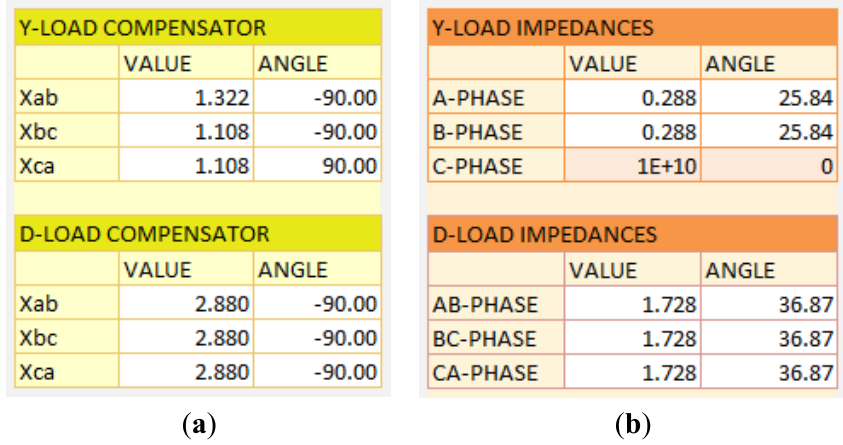
Figure 9. Selection of: ( a ) the compensation devices, ( b ) the optimal distributed wye load.